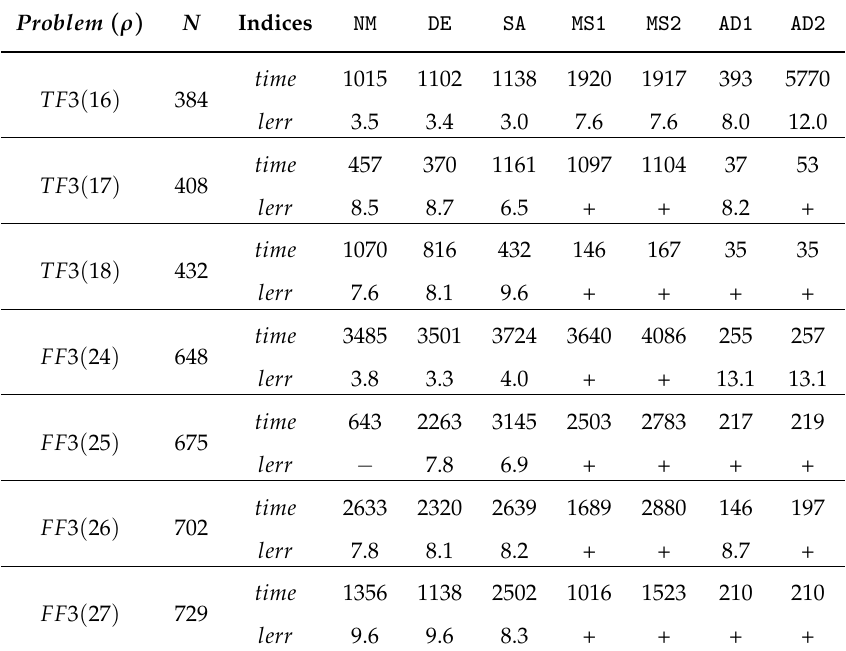
Table 4. Execution times and accuracies for the tensor factorization associated to matrix product complexity.